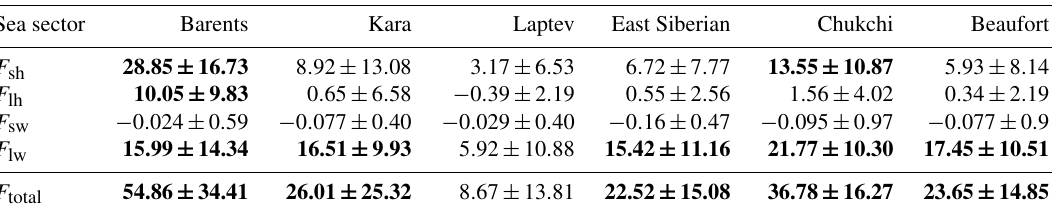
Table 1. Regional averaged F sh , F lh , F sw , F lw , and F total in Kara, Laptev, East Siberian, and Beaufort sectors. The unit is Wm − 2 for all variables. Statistically significant positive values are in bold.